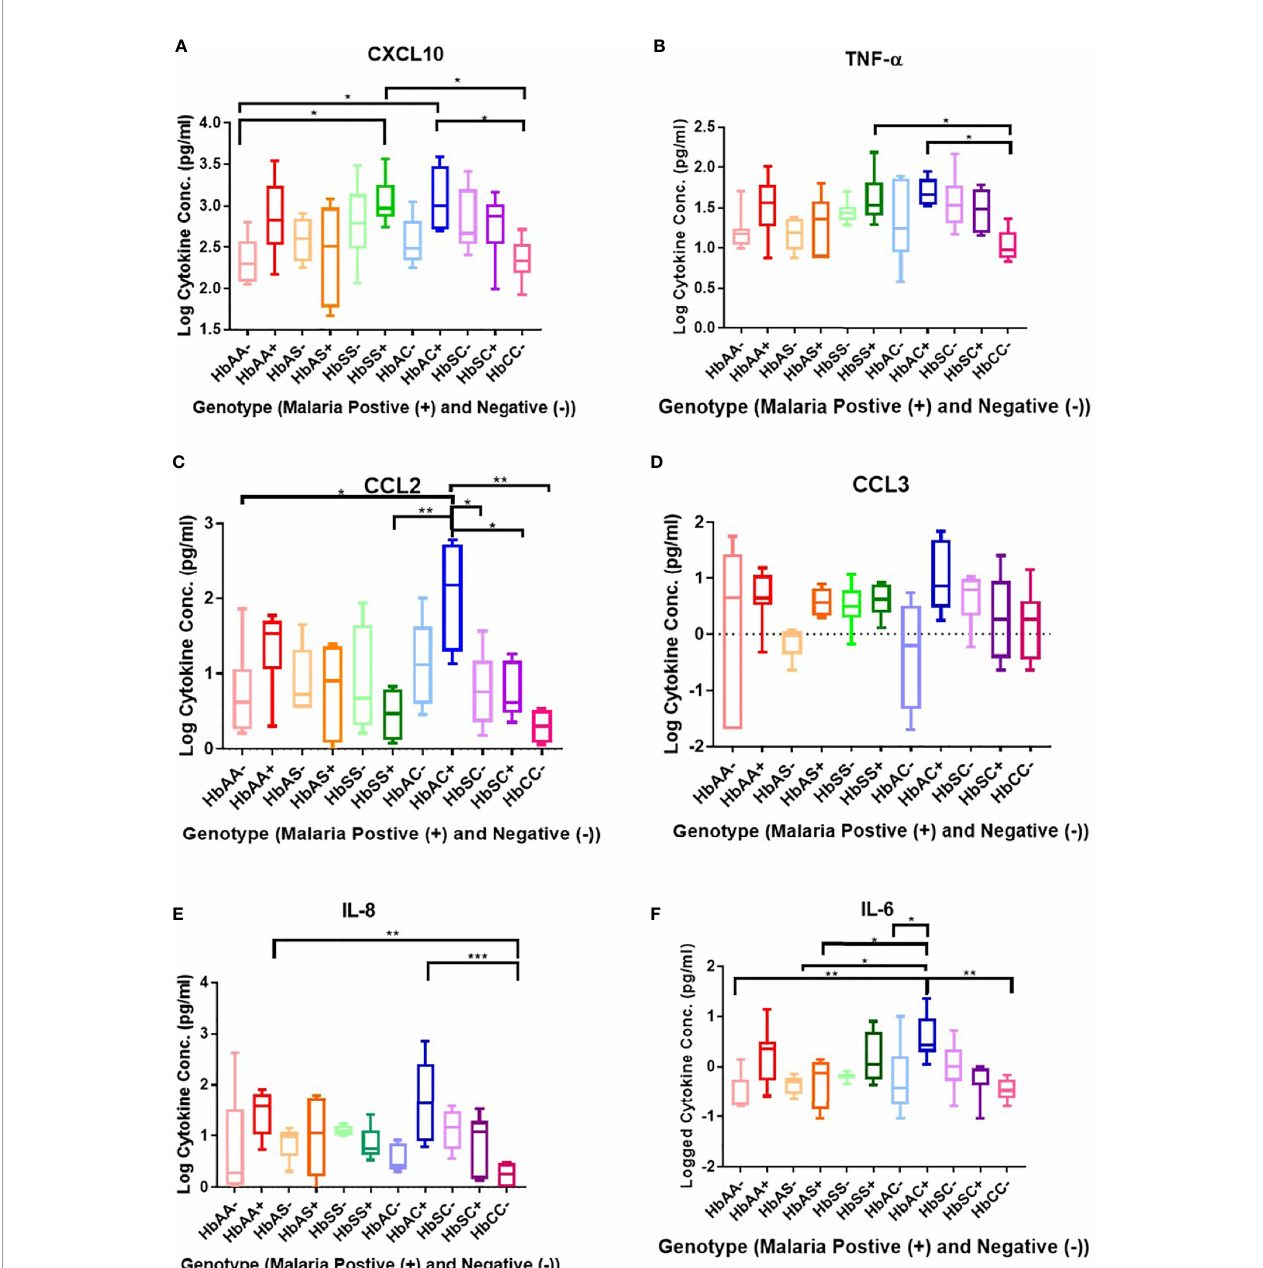
FIGURE 1 | Comparisons between Hb genotypes and in fl ammatory cytokines with and without Plasmodium infection. A one-way ANOVA and Tukey ’ s multiple comparison test was used to assess between all the genotypes with (+) and without (-) malaria. Graphs are box and whisper plots showing minimum and maximum values. (A) Assessment of CXCL10 in different Hb genotypes that were infected or uninfected with malaria: HbAA- vs HbSS+ (P = 0.01), HbAA- vs HbAC+ (P = 0.02), HbSS+ vs HbCC- (P = 0.01), and HbAC+ vs HbCC- (P = 0.02). (B) Assessment of CCL2 in different Hb genotypes that were infected or uninfected with malaria: HbAA- vs HbAC+ (P = 0.02), HbAC+ vs HbSS+ (P = 0.007), HbAC+ vs HbSC- (P = 0.04), HbAC+ vs HbSC+ (P = 0.04), and HbAC+ vs HbCC- (P = 0.002). (C) Assessment of TNF- a in different Hb genotypes that were infected or uninfected with malaria: HbCC- vs HbSS+ (P = 0.04) and HbCC- vs HbAC+ (P = 0.02). (D) Assessment of CCL3 in different Hb genotypes that were infected or uninfected with malaria: no signi fi cant differences observed. (E) Assessment of IL-8 in different Hb genotypes that were infected or uninfected with malaria: HbAA+ vs HbCC- (P = 0.005) and HbAC+ vs HbCC- (P = 0.0009). (F) Assessment of